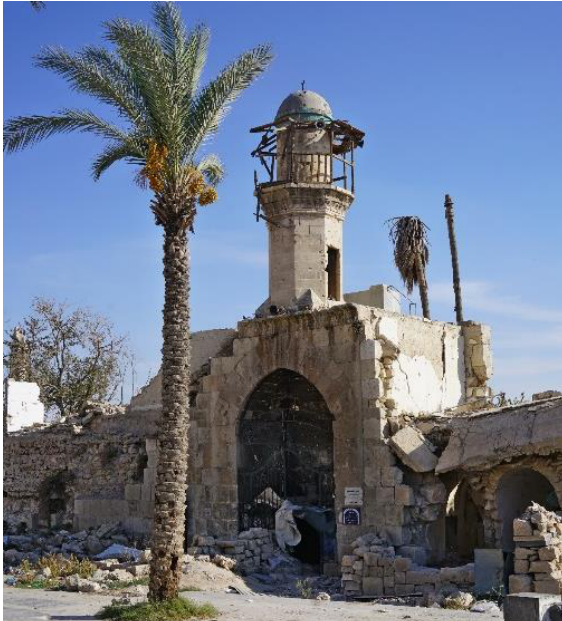
Figure 12. Al-Sultanieh, Mosque, Ayyubids, 1223 D.C. It contained the tomb of Zaher al-Ghazi, son of Saladin, the governor who restored the Citadel and built the walls.